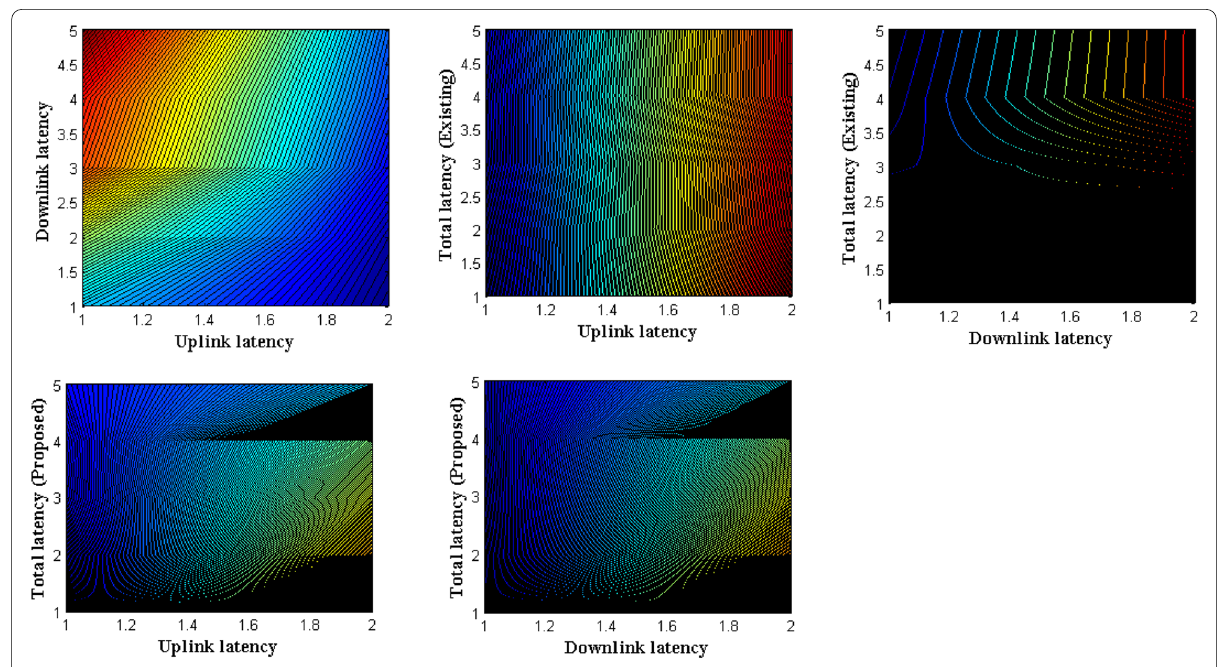
Fig. 3 Latency periods with synchronization